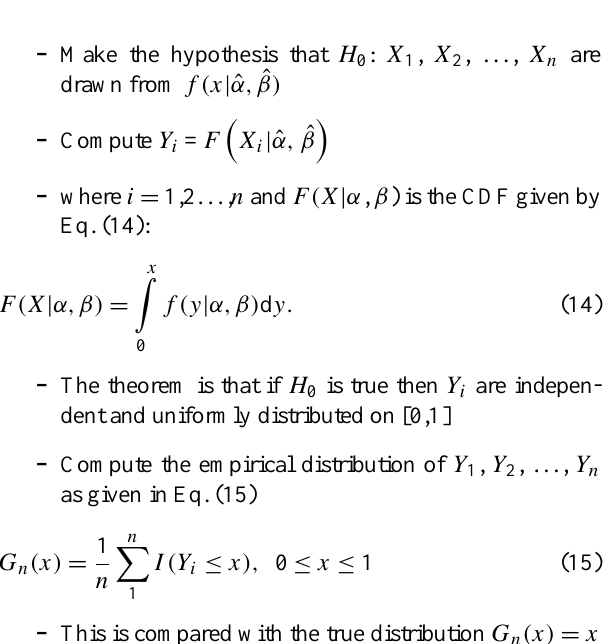
Fig. 3. Gamma Q–Q plots for the observed IL